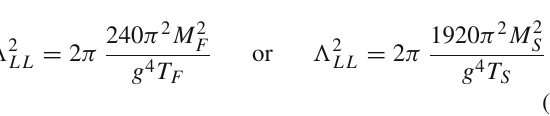
Fig. 1 Translation of the experimental bounds on Wilson coefficients as in Table 1 to the ( J R , M R ) parameter space: masses above the curves are allowed by the individual measurements. Shown are the cases of a fermion multiplet (left panel) and a scalar multiplet (right panel). For